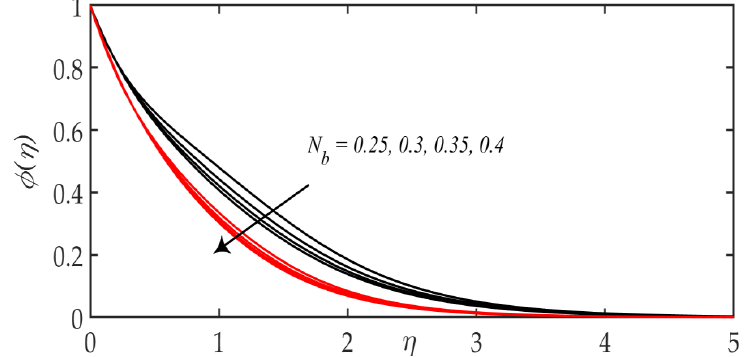
Figure 8. Variation of 𝑁 𝑡 and 𝐿 𝑒 on concentration profile. Solid line: 𝑁 𝑡 = 5 , Dotted line: 𝑁 𝑡 = 10.